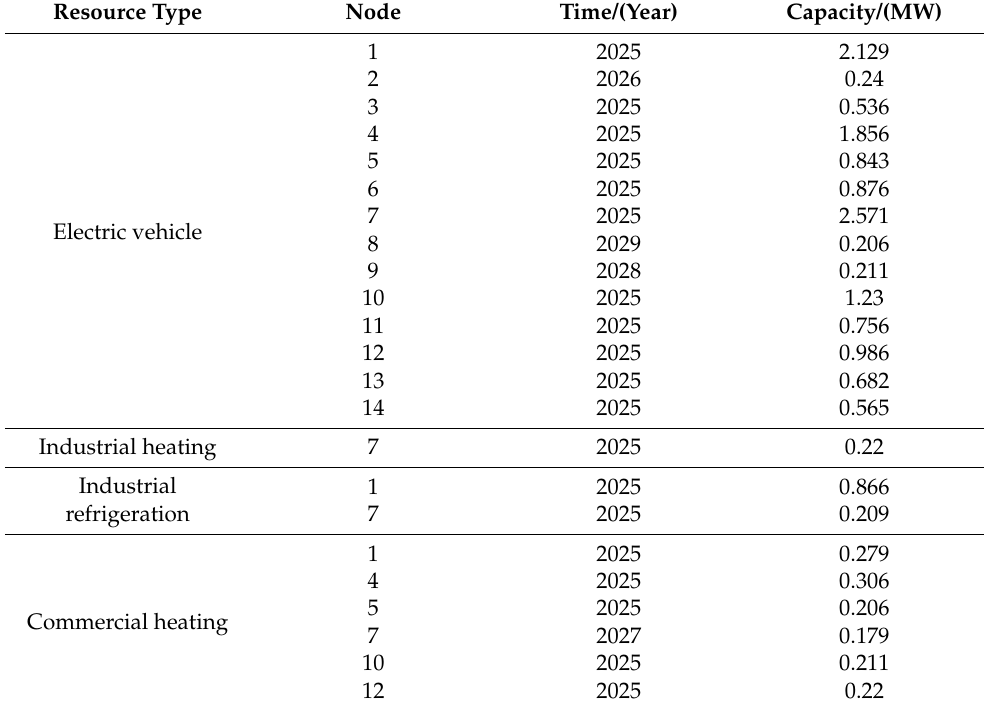
Table 2. Optimal allocation results of distribution network resources from 2025 to